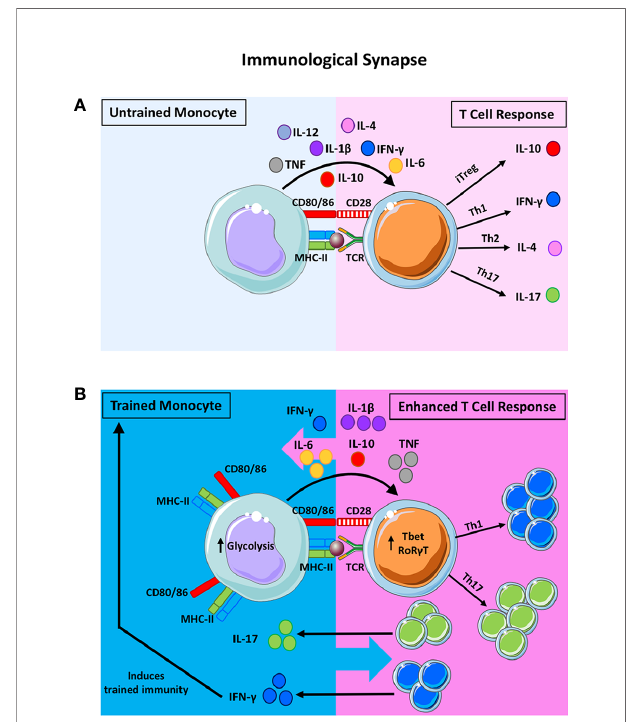
FIGURE 1 | The potential impact of trained immunity on the bidirectional innate-adaptive immune synapse. The traditional synapse between antigen- presenting cells (APC) and naïve T helper cells is depicted in (A) . The innate APC processes and presents antigen on the MHC-II molecule to provide the fi rst signal to activate the T cell. Upregulation of co-stimulatory molecules on the APC and their ligation to the cognate receptors on the T cells provide the second signal required for T cell activation. Cytokine production by the innate APC then polarises the naïve T cell into discreet subsets. For example, the presence of IL-10 will induce the formation of T regulatory cells (Treg) whereas IL-12 and IFN- g will polarise T cells towards a Th1 lineage. IL-4 promotes Th2 polarisation and IL-1 b and IL-6 (along with other innate cytokines) promote Th17 development. This synapse is often viewed as unidirectional, however, there is evidence to suggest that T cell cytokines can impact also APC function. In addition to being the critical control point in the polarization of naïve T cells, this synapse is also crucial for reactivating memory T cells in tissues. Under these circumstances, innate cytokine production can alter the functional pro fi le of previously lineage committed T cells. When trained immunity is induced in innate cells, their APC function and cytokine production is markedly enhanced (B) . Trained innate cells exhibit increased expression of MHC-II, costimulatory molecules (CD80/CD86) and an upregulation of aerobic glycolysis. Moreover, trained monocytes produce signi fi cantly more TNF, IL-1 b and IL-6 compared with untrained monocytes. These features of proin fl ammatory innate immune training suggest that T cell polarization may be skewed in favour of Th17/Th1 responses, as indicated by the expression of the master transcription factors ROR g T and Tbet, respectively. In the same manner, lineage committed T cells that are prone to functional plasticity, such as the Th17 and Treg lineages, may be altered by trained immunity and directed down alternative lineage fates. Enhanced IFN- g and IL-17 production from T cells can impact innate cell function. In fact, IFN- g production has been shown to induce trained immunity in tissue resident macrophages. Notably, alternative types of trained immunity that result in enhanced IL-10, for example, will alter T cell fate towards Treg cells, which may in turn impact innate APC function. We propose that, trained immunity alters T cell fate and function which may in turn alter innate cell function. Depending on the primary insult that induces trained immunity, the pro-in fl ammatory versus anti-in fl ammatory nature of this bi-directional synapse will be altered depending on the cytokine milieu and the cellular functions that are induced by trained